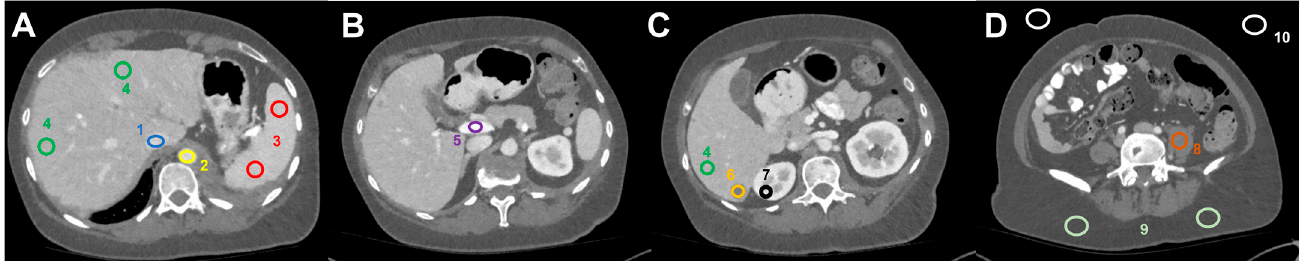
Figure 1. Image analysis and ROI-based measurement of mean HU values (and standard deviation) in dedicated regions: ( A ) (1) inferior vena cava, (2) abdominal aorta, (3) spleen, (4) liver parenchyma, ( B ) (5) portal vein, ( C ) (6) liver metastasis, (7) right renal cortex, ( D ) (8) left psoas muscle, (9) subcutaneous tissue (2×), and (10) air (2×).